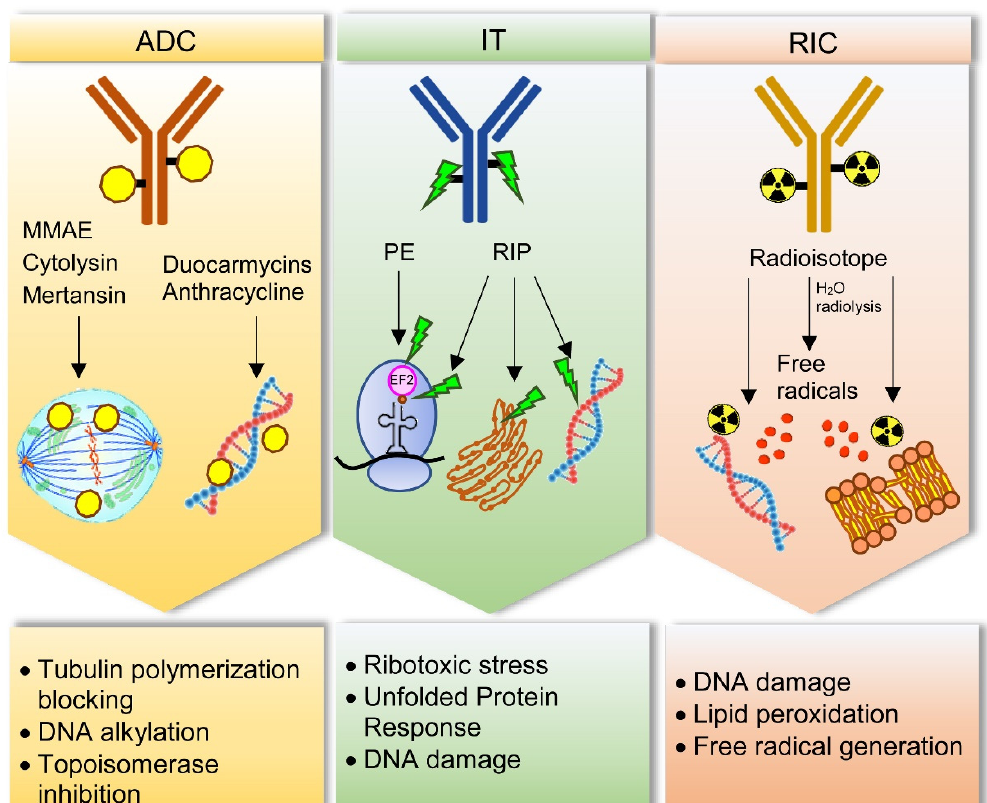
Figure 1. Main cell damage mechanisms induced by immunoconjugates for sarcoma treatment. Antibody–drug conjugates (ADC) can contain drugs acting with different mechanisms. Monomethyl auristatin E (MMAE), cytolysin and mertansin block tubulin polymerization, thus hampering cell cycle. Duocarmycins and anthracycline target DNA, inducing alkylation and topoisomerase inhibition, respectively. Immunotoxins (IT) can be constructed with Pseudomonas exotoxin (PE) or ribosome-inactivating proteins (RIPs). PE inhibits elongation factor-2 (EF2) through its ADP-ribosylation, thus inducing ribotoxic stress and protein synthesis blocking. RIPs can inhibit protein synthesis through rRNA-N-glycosylase activity removing a specific adenine in a stem–loop region of the main ribosomal RNA. In addition, RIPs can act on different substrates such as endoplasmic reticulum, through unfolded protein response, and DNA, by directly damage. Radioim- munoconjugates (RIC) contain radioisotopes, which can damage DNA and cause lipid peroxidation in cell membranes. This effect can occur directly or indirectly through free radicals produced by water radiolysis.